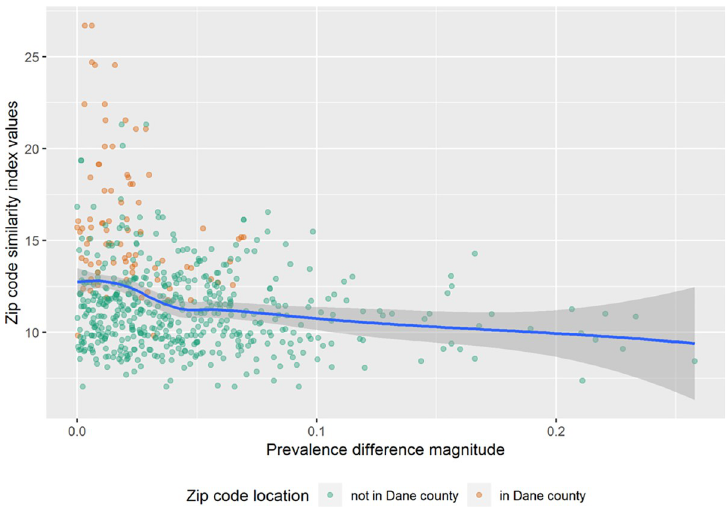
Fig 2. Scatter plot showing prevalence difference estimates versus zip code similarity indices between Wisconsin Health Atlas and University of Wisconsin Public Health Information Exchange.